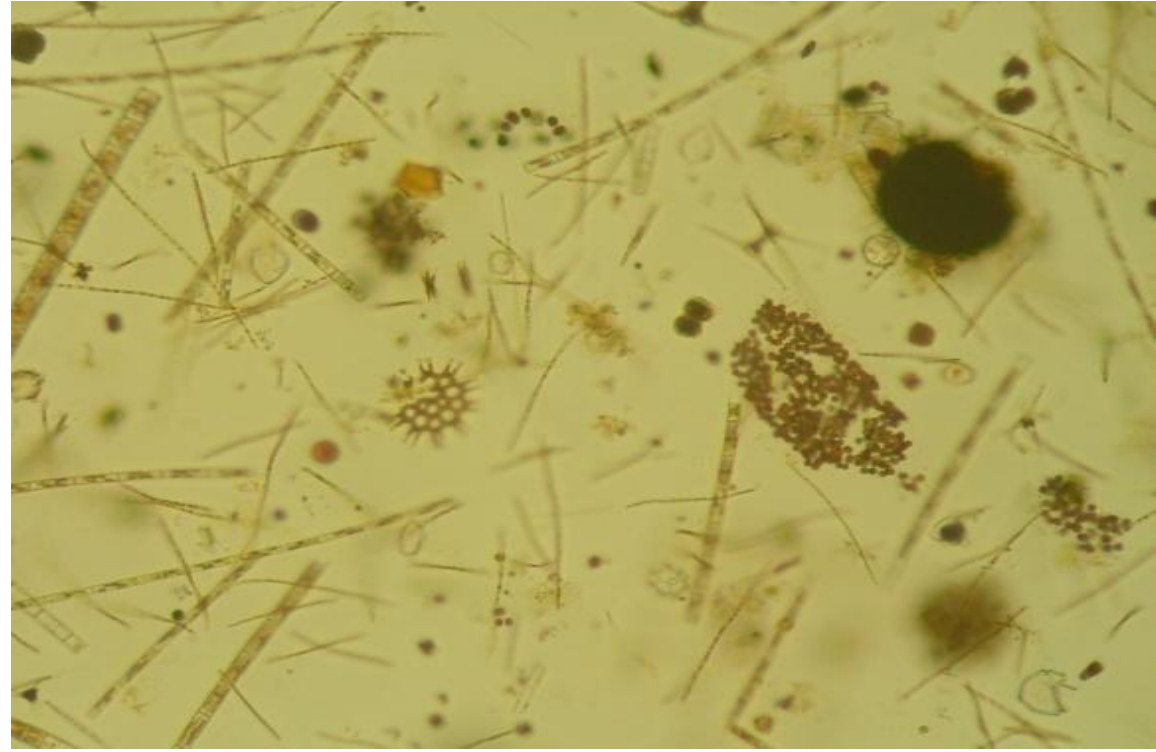
Figure 1: Phytoplankton diversity of Konduwattuwana Tank: Note numerous small filaments of Cylindrospermopsis , few colonies of Microcystis , several desmids and the diatom